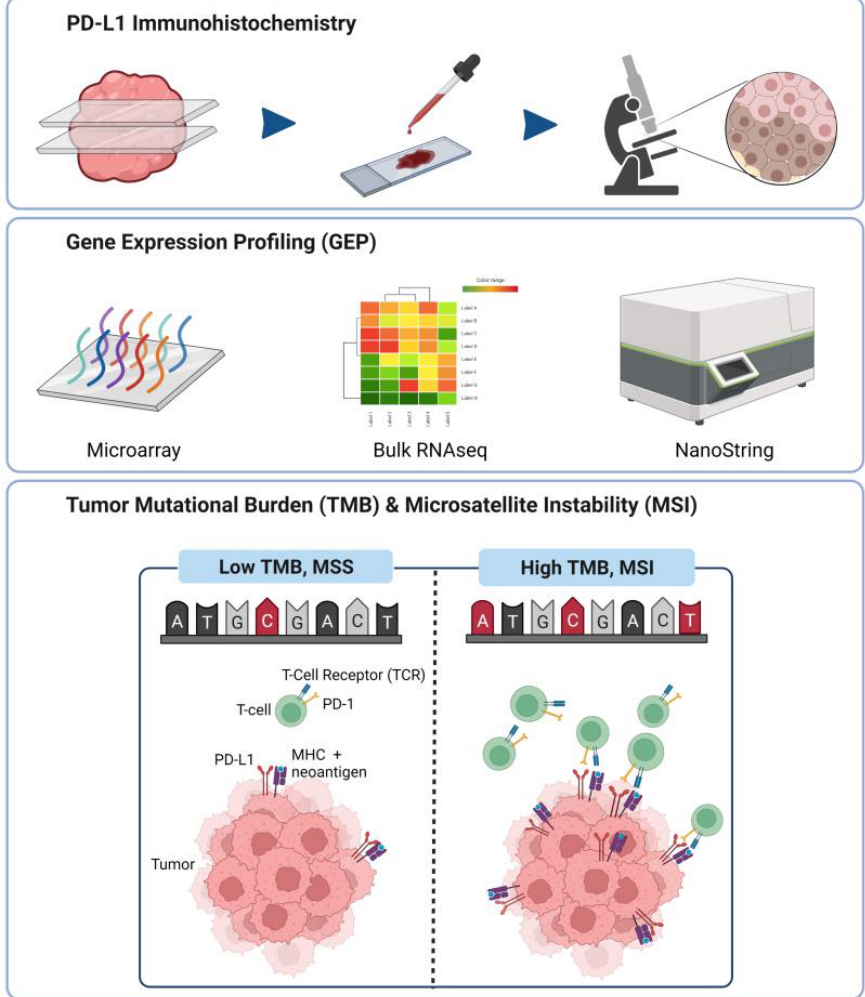
Figure 1. Conventional technologies used for prediction of ICI benefit in cancer patients.